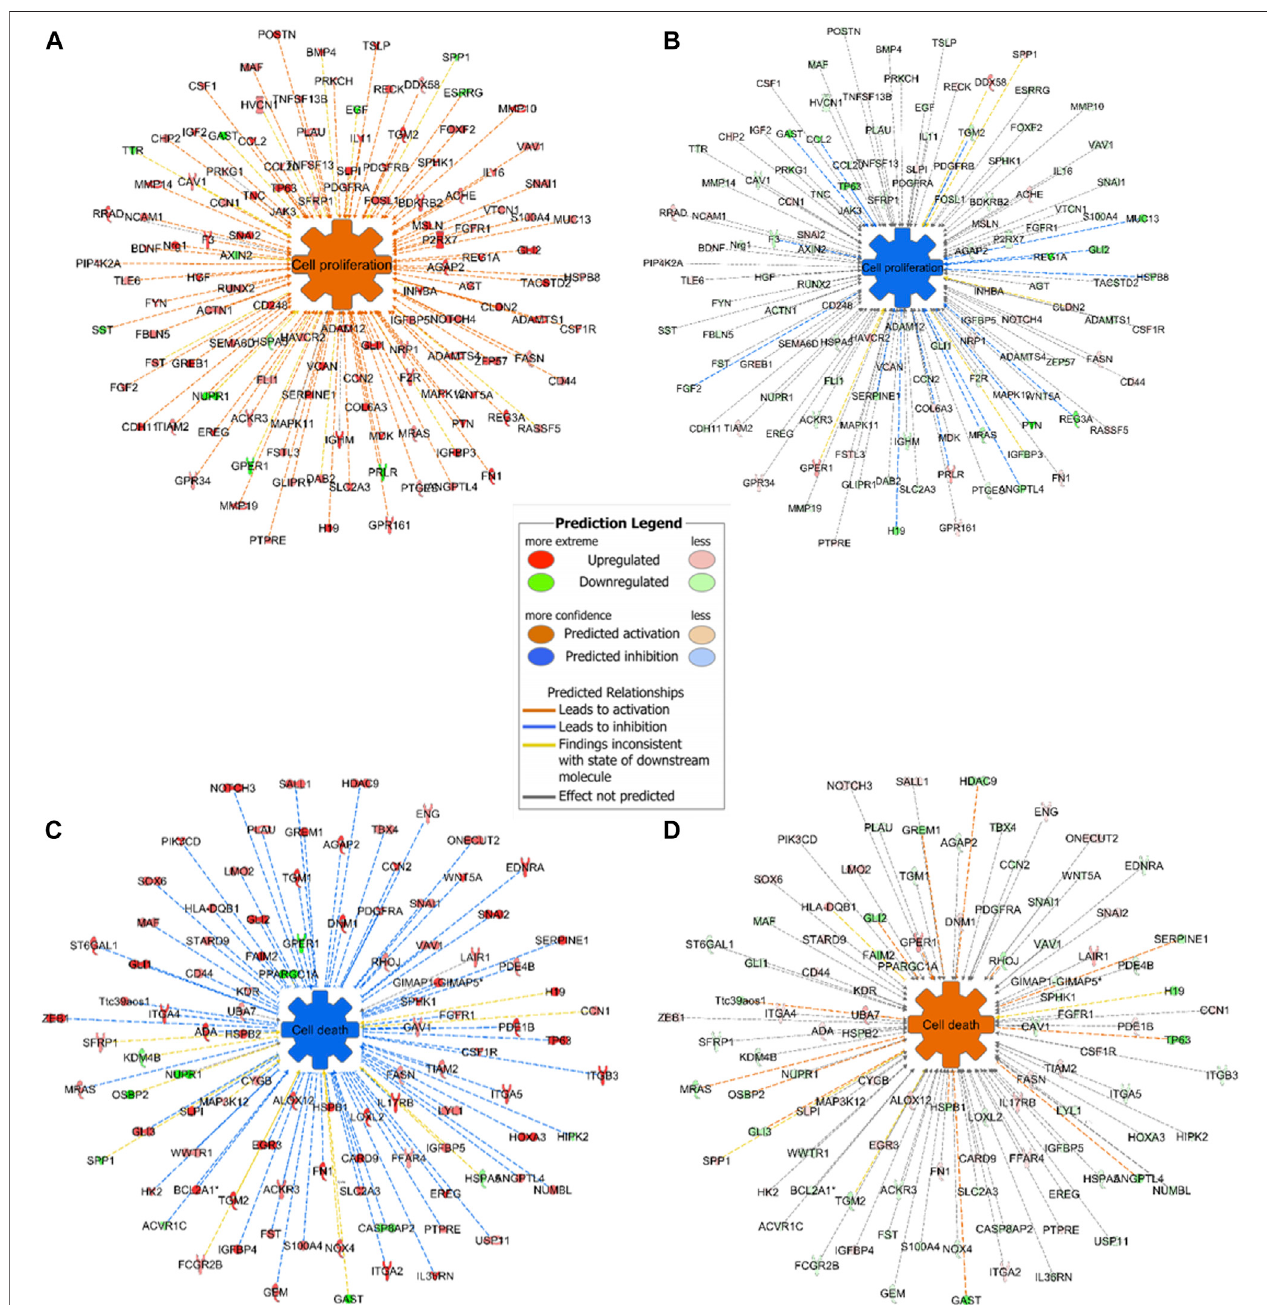
FIGURE 7 | Representative networks of cell proliferation and cell death in mice with or without ivermectin treatment. (A) Mouse GC cell proliferation network was created using BioPro fi ler in IPA. Only genes differentially expressed ( p < 0.05, Log 2 FC ± 1.0) between mouse GC vs. WT were included. Overexpression of genes in the networkresultsinactivationofcellproliferation(orange; z -score > 0). (B) GenesinthecellproliferationnetworkwasdownregulatedinGCmicewithivermectintreatment (blue; z -score < 0). (C) MouseGCcelldeathnetworkincludingapoptoticmarkerswascreatedusingBioPro fi lerinIPA.Onlygenesdifferentiallyexpressed( p < 0.05, Log 2 FC ± 1.0) between mouse GC vs. WT were included. Overexpression of genes in the network results in inhibition of cell death (blue; z -score < 0). (D) Cell death network was aberrantly expressed in GC mice with ivermectin treatment (orange; z -score > 0).